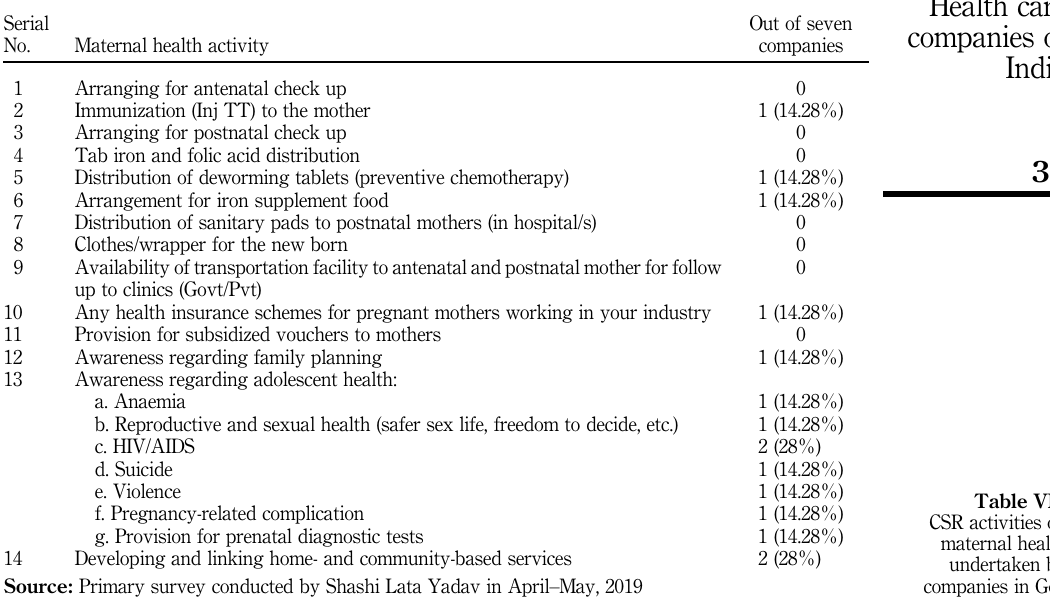
Table VII. CSR activities